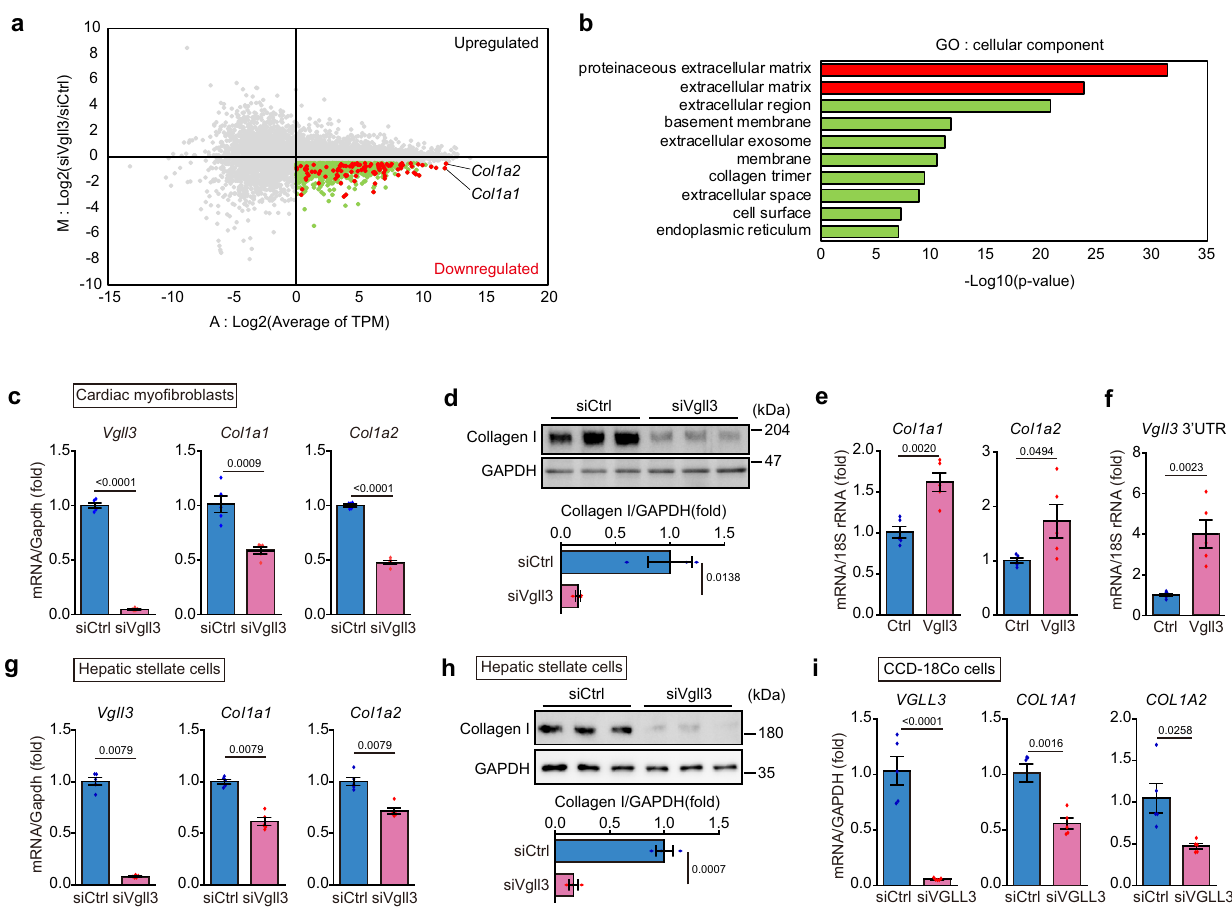
Fig. 3 | Vgll3 promotes fi brosis-related gene expression in myo fi broblasts. a Representative MA plot of RNA-seq data demonstrating upregulated or down- regulatedgenesbysi Vgll3 treatmentincardiacmyo fi broblasts.Redandgreendots represent genes downregulated by si Vgll3 treatment ( M < − 0.5, A >0). Red and greendotsrepresentproteinaceousextracellularmatrixgenes/extracellularmatrix genes and the other genes shown in ( b ), respectively. b Enrichment analysis of ontology forthe genesdownregulated by si Vgll3 treatment. c mRNA levelsof Vgll3 and fi brosis-related genes in cardiac myo fi broblasts transfected with siRNA (#1) targeting Vgll3 ( n =5 each). d Protein levels of Collagen I and GAPDH in cardiac myo fi broblaststransfectedwithsiRNA(#1)targeting Vgll3 ( n =3each). e Col1a1 and Col1a2 mRNA levels in NIH3T3 cells overexpressing FLAG-VGLL3 ( n =5 each).